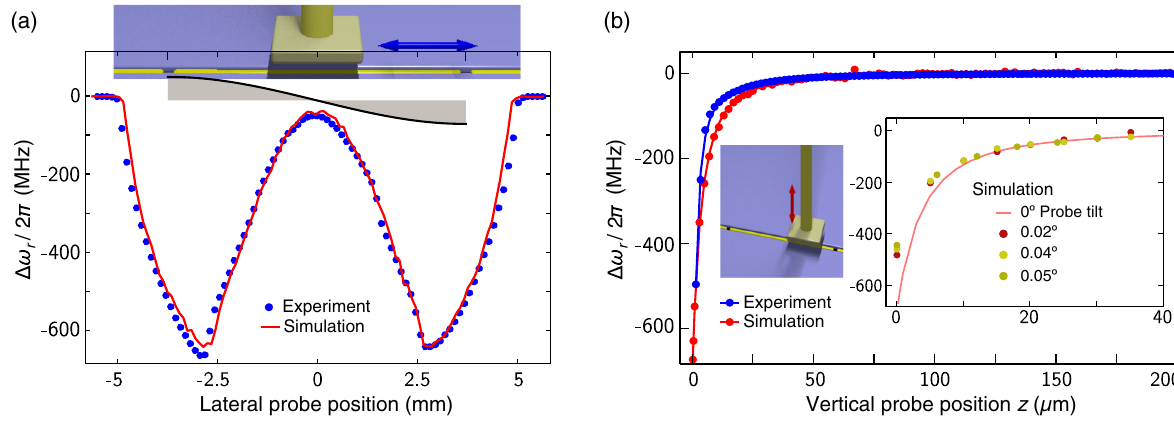
FIG. 2. Verification of probe performance and calibration for a single resonator. (a) Measurement data of the resonator frequency shift as a function of probe position along the resonator agree well with predictions from finite-element simulation (using a 2 μ m probe height). In the experiment, the probe is centered over and placed into mechanical contact with the resonator for each data point. The frequency shifts follow the field distribution of the λ = 2 mode, with shift maxima for probe positions close to the resonator ends where the field is strongest and a shift minimum at the resonator midpoint. (b) The calibration of the resonator frequency shift (defect size) with respect to vertical distance of the probe from the resonator is performed at the lateral position of maximum shift. After adjusting for an offset in the z direction, finite-element simulation and measurement data agree over most of the vertical distance range. Deviations observed at the smallest probe heights may be due to a small tilt of the dielectric probe with a misalignment angle as small as 0.02°, as indicated by simulations shown in the